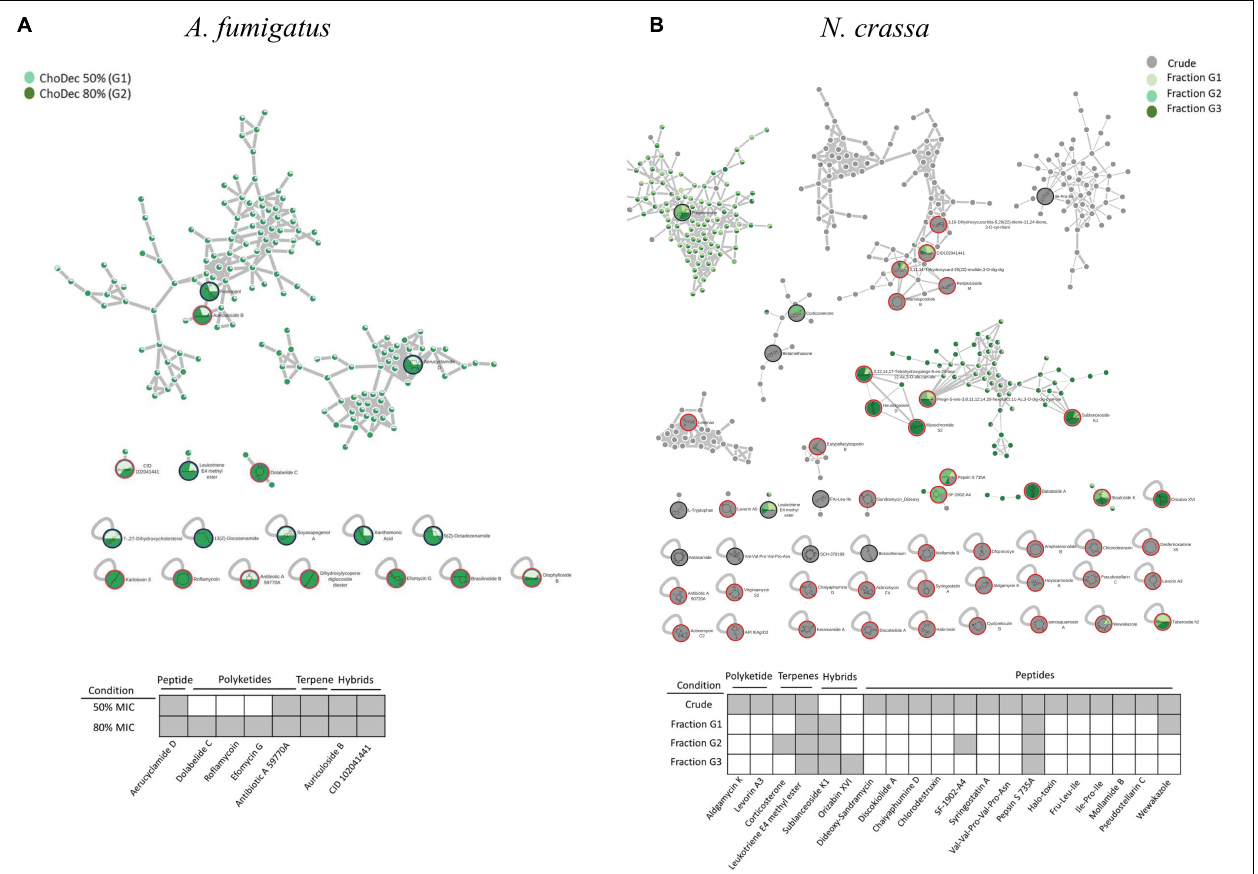
FIGURE 5 | The molecular network generated by the GNPS tool using the MS data acquired for A. fumigatus (A) and N. crassa (B) extracts derived from ionic liquid supplemented cultures, considering the putatively identified compounds the accumulation, among other metabolites of macrolides and peptides, respectively. Putative identifications retrieved by using molecular networking analysis and compound dereplication in GNPS, from spectral match (*) and in silico tool DEREPLICATOR + . For N. crassa , isolated fractions (G1, G2, and G3) as well as crude (G4) extracts were analyzed; whereas for A. fumigatus , extracts from cultures supplemented with choline decanoate at 50% (G1) and 80% (G2) of the MIC. Only peaks with signal intensity > 1.5 · 10 7 (for A. fumigatus : G1 and G2) and > 3 · 10 7 (for N. crassa : G4) in the total ion chromatogram are depicted (Full list in Supplementary Table 3 ). For N. crassa fractions, G1 to G3, the two most intense peaks in the total ion chromatogram are